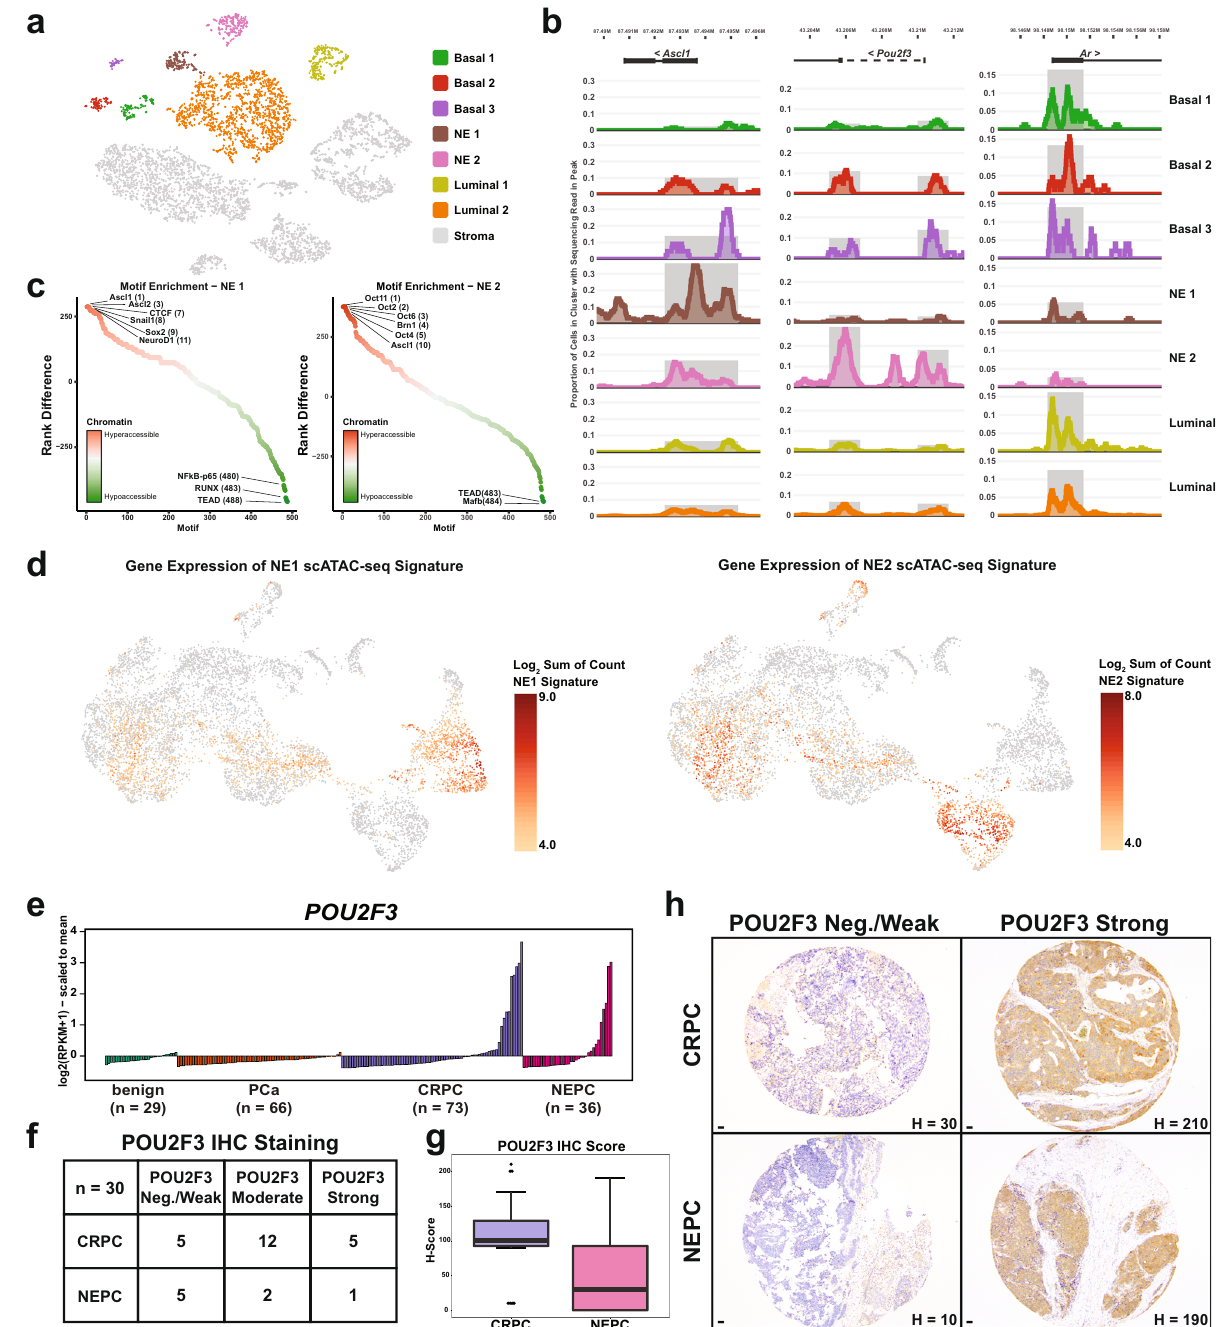
Fig. 5 Distinct chromatin accessibility patterns exist in neuroendocrine subpopulations. a t-SNE plot of scATAC-seq data from PRN mice. b Chromatin accessibility in the subpopulations at the indicated loci. c Graphs of differential transcription factor motif enrichment in the indicated NE subpopulations called on regions of hyper-accessible and hypo-accessible chromatin between clusters. d Gene expression levels of the top 50 most differentially accessible genes in the NE1 and NE2 populations. Genes identi fi ed in Supplementary Table 5 and projected onto UMAP from Fig. 4g. e POU2F3 expression in benign ( n = 29), locally advanced prostate cancer (PCa) ( n = 66), CRPC ( n = 73), and NEPC ( n = 36) patient samples. f Summary of POU2F3 IHC staining on clinical tissue microarray. g Quanti fi cation of IHC scores in TMA by patient diagnosis (CRPC: n = 22; NEPC: n = 8). Box represents 25% − 75% percentile with median denoted as a line. Whiskers extend + / − 1.5× interquartile range. Data points that lie outside the whiskers are plotted individually. h Representative images of POU2F3-strong and POU2F3-negative/weak patient samples. Scale bar: 50 μ